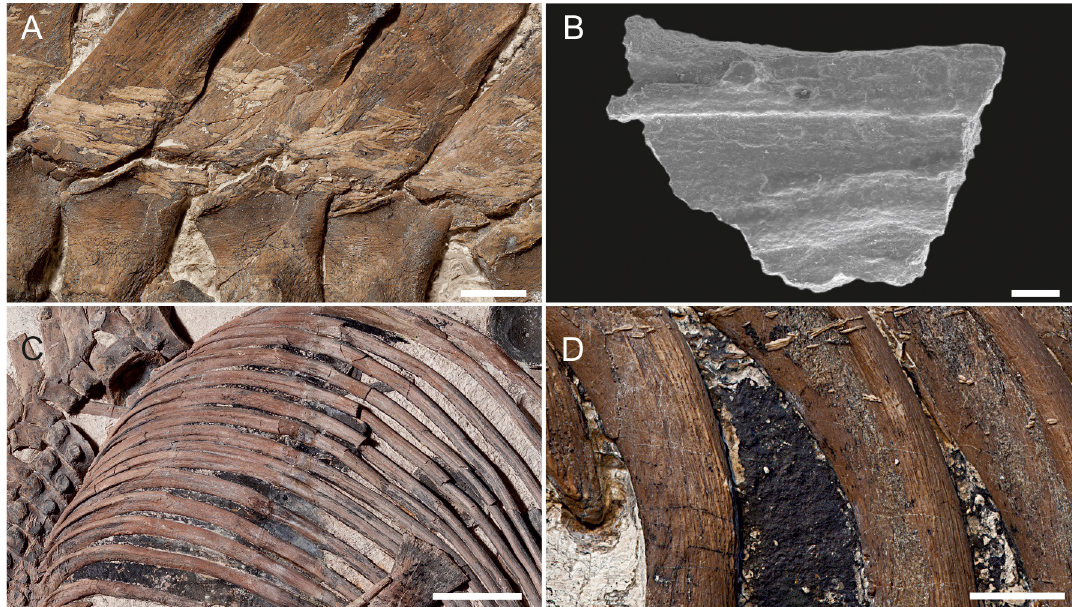
Fig 19. Summary of the taphonomic history of Thalassodraco etchesi , MJML K 1885. A, B, the carcass drifts in the water column, with the heavier head directed to the seafloor. C, the heavier skull arrives on the seafloor, with the skull penetrating the soft sediment, until it hits the harder, dewatered sediment below. D, the carcass starts to collapse laterally. If the gut and lungs are filled with gas, the posterior portion will remain buoyant, remaining out of the sediment. E, the carcass collapses and decomposes. The portion within the sediment remains articulated, whereas the posterior and right lateral portions are exposed to scavenging and scattering of bones through current action. Arrows indicate later compaction of the specimen as the sediment dewaters. Modified from Martill [65, 66].